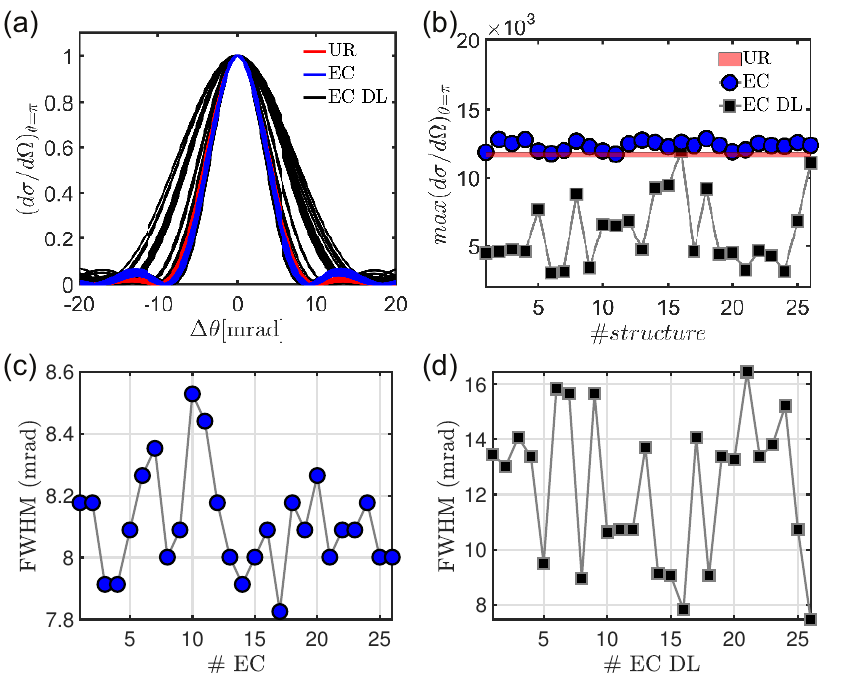
Figure 14. ( a ) Normalized backscattering cone of different representative EC (blue lines) and EC DL (black lines) structures as compared to 20 different disorder realizations of traditional uniform random arrays (red lines). Table 1 summarizes the averaged structural parameters of the different analyzed devices. Specifically, the EC arrays were selected equidistantly from the 900 different EC structures generated by all the possible combination of the coefficients A and B in the range (1, 30) ordered by following the ˆ Γ trend of Figure 6. In the same way, the 26 different EC DL arrays were selected equidistantly from the 32 EC DL point patterns, generated as discussed in Section 3, order by following the ˆ Γ trend of Figure 11. ( b ) Intensity peak of the differential scattering efficiency evaluated in the backward direction by using Equation (36). Panels ( c , d ) report, respectively, the full width half maximum of the backscattering cone of the EC and EC DL aperiodic